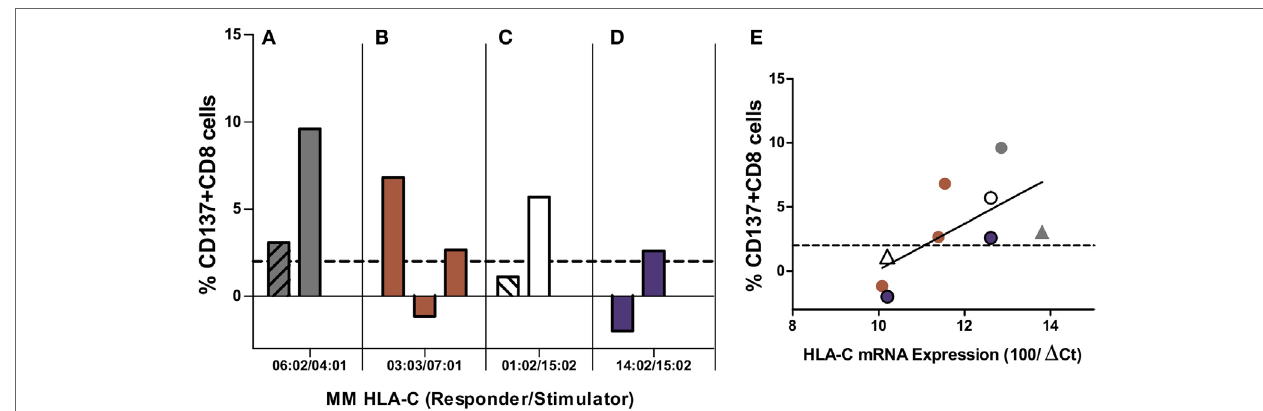
FigUre 7 | Mixed lymphocyte reactions (Mlrs) between different hla-c MM stimulators and the same responder . Each panel represents MLRs between responder cells isolated from the same individual and HLA-C MM stimulator cells from two to three different individuals. MLRs of each panel were performed in parallel (i.e., at the same time) for each experiment and represent four different HLA-C MM: the mismatched HLA-C alleles of the responder and the stimulator are indicated below each panel. Alloresponses are given as % Δ CD137 + CD8 + cells (2% cutoff indicated by the dashed line). All pairs were DPB1 incompatible except two pairs [dashed bars in (a,c) ]. (e) shows the correlation between HLA-C mRNA expression of the stimulator cells and the induced alloresponse (% Δ CD137 + CD8 + cells): r = 0.42, p = 0.056. Triangles correspond to HLA-DPB1-matched pairs. All other MLRs were HLA-DPB1 mismatched. Colors in (e) correspond to those used in (a–D) .